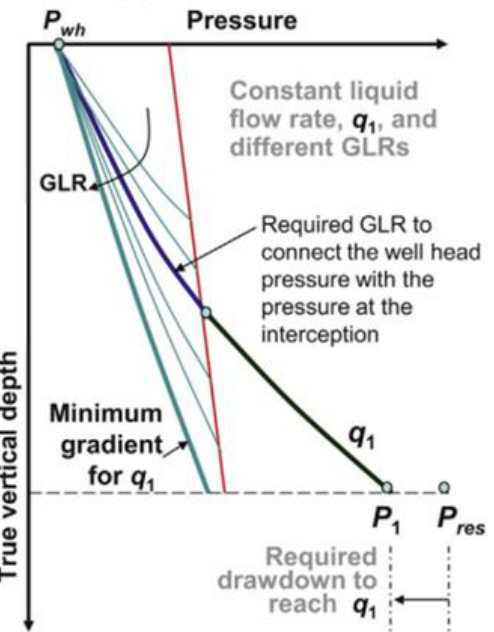
Figure 9. Procedure to find the liquid production at different pressure gradients.